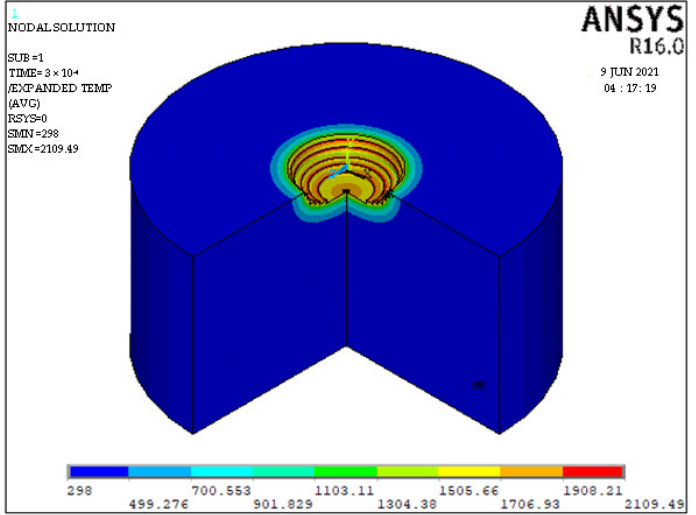
Figure 2. Predicted crater shape for Φ 40 µ m at discharge duration 300 µ s, peak current 6 A and gap voltage 80 V.